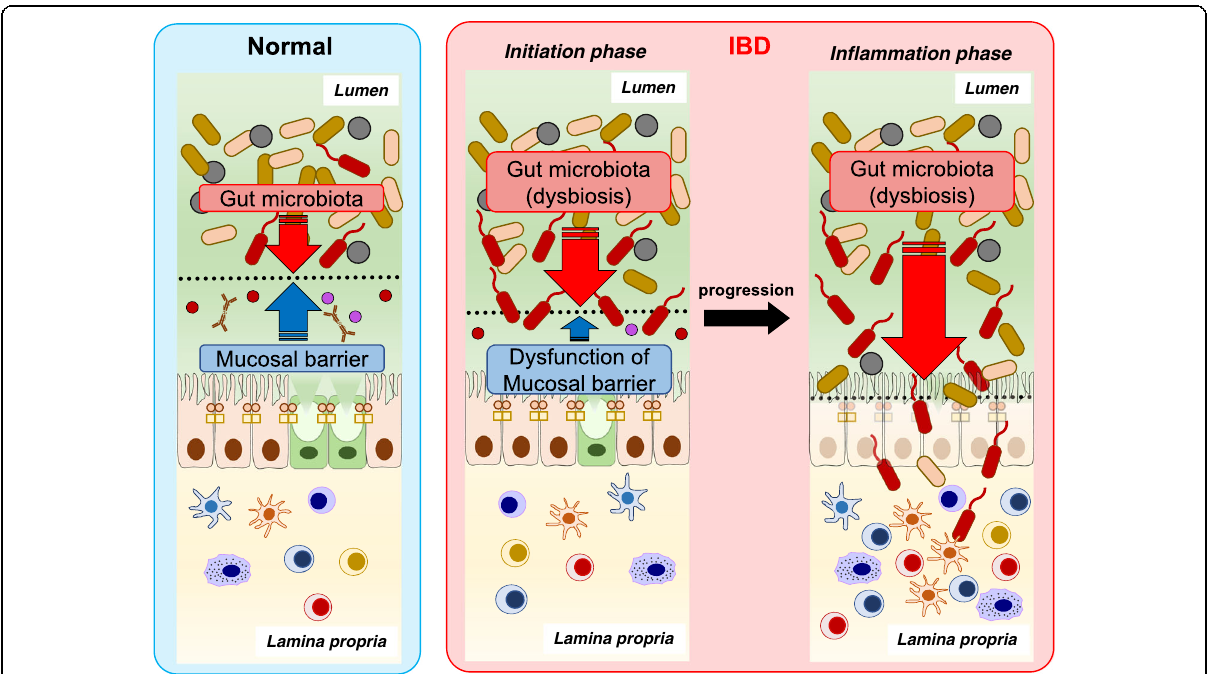
Fig. 3 The imbalance between mucosal barriers and gut microbes promotes susceptibility to intestinal inflammation. In the steady state, intestinal bacteria and mucosal barriers maintain a well-balanced relationship, and thus intestinal bacteria and IECs are clearly segregated in the gut. However, dysfunction of mucosal barriers including decreased production of mucin or AMPs due to genetic factors and dysbiosis induced by environmental factors such as high-fat diet or various antibiotics disrupt the well-balanced relationship, and thereby intestinal bacteria can gain access to the gut immune cells, leading to the progression of IBD. IBD: inflammatory bowel